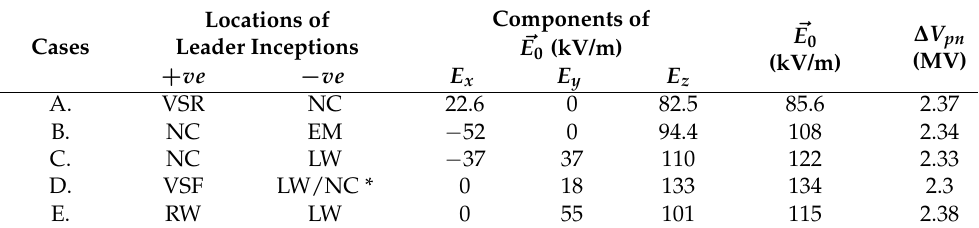
Figure 11. Four cases with different relative orientations of ambient field with respect to aircraft are considered. In all the cases, position and orientation of the aircraft have been kept same as mentioned in Section 3. Inception points and discharge paths of the connecting leaders for Case-A, B, C, D are shown in ( a – d ) respectively. Corresponding bi-polar leader progression from aircraft and variation of aircraft potential are shown in ( e – h ). Table 1. Minimum ambient field ( (cid:126) E 0 ) required for stable bi-polar discharge from DC-10 aircraft for different positive and negative leader inception locations (Figure 11). Corresponding difference in ambient potential ( ∆ V pn ) between the leader inception locations are also